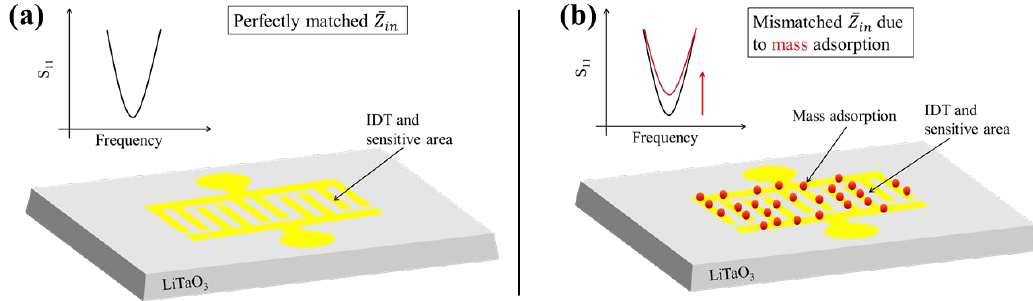
Figure 1. Schematic drawing of the surface acoustic wave (SAW) sensor concept. ( a ) The bare SAW sensor surface with perfectly matched Z in ; ( b ) The red dots symbolize deposited mass on the interdigital transducer (IDT) surface, leading to a change of S 11 due to the mismatch of Z in . The drawings are not to scale.